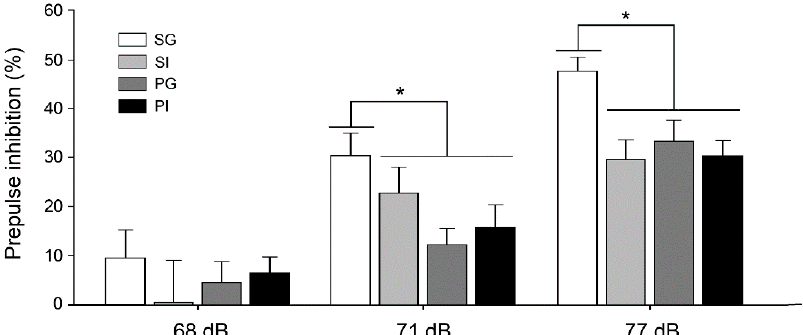
Figure 3. Behavioral examination of sensorimotor gating. The property of sensorimotor gating was assessed using prepulse inhibition (PPI) of the acoustic startle reflex. Results are mean ± SEM ( n = 8–12 per group). * p < 0.05.